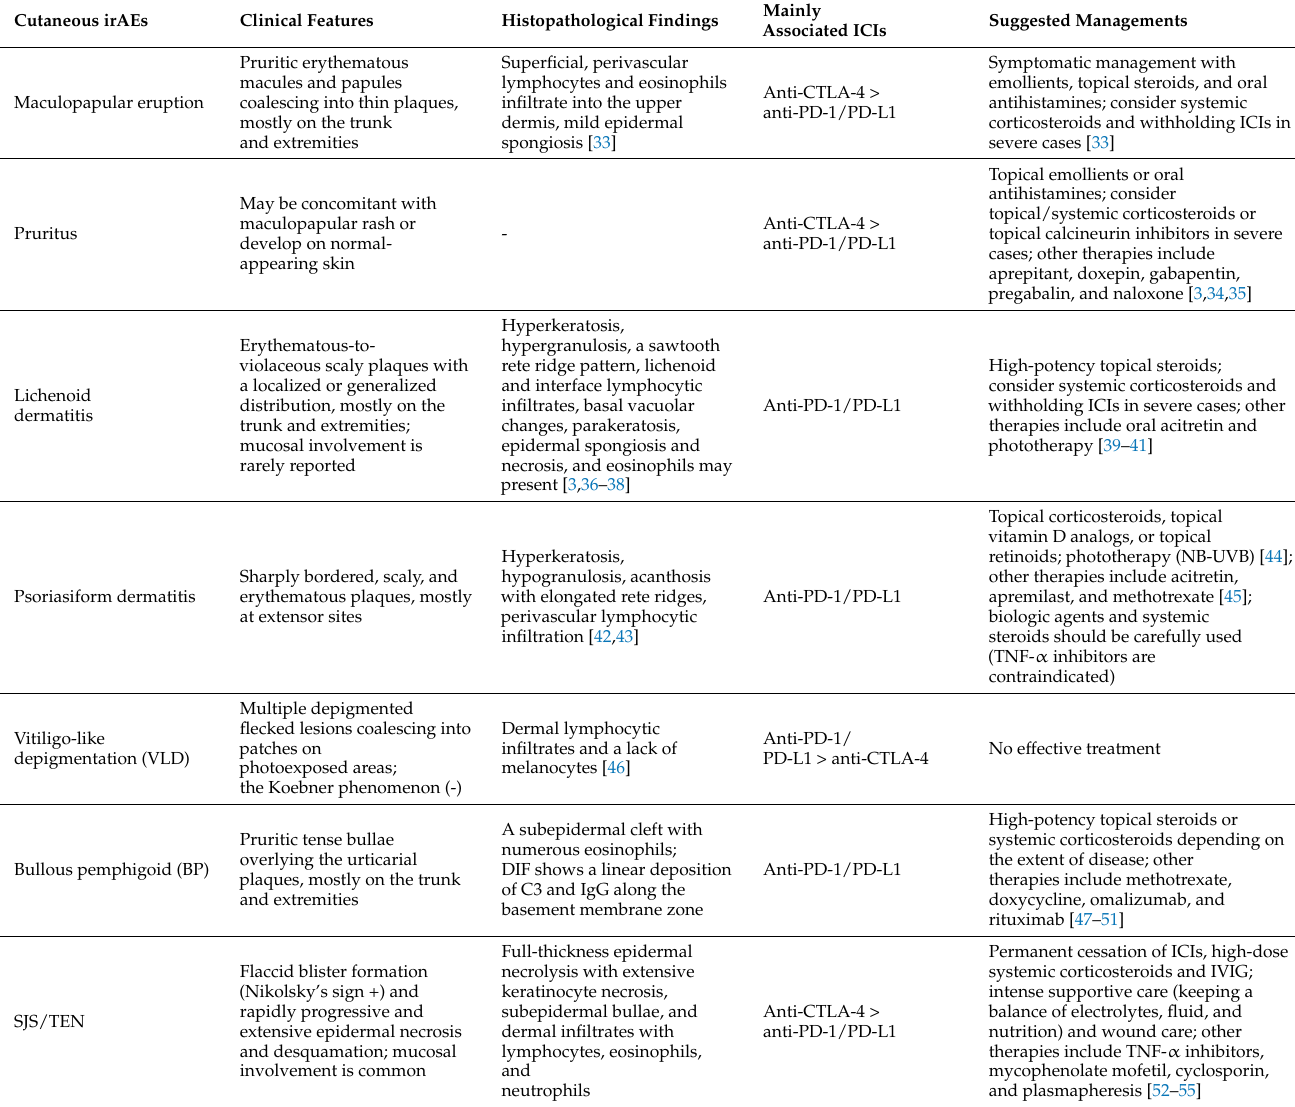
Table 2. Summary of relatively common cutaneous adverse events associated with immune check- point